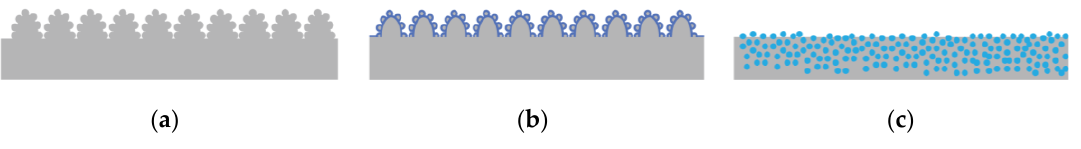
Figure 3. Cross-sectional schematic diagrams of: ( a ) an intrinsically rough superhydrophobic surface; ( b ) a rough surface modified by low surface energy material to achieve superhydrophobicity; ( c ) metal matrix composite with hydrophobic particles.